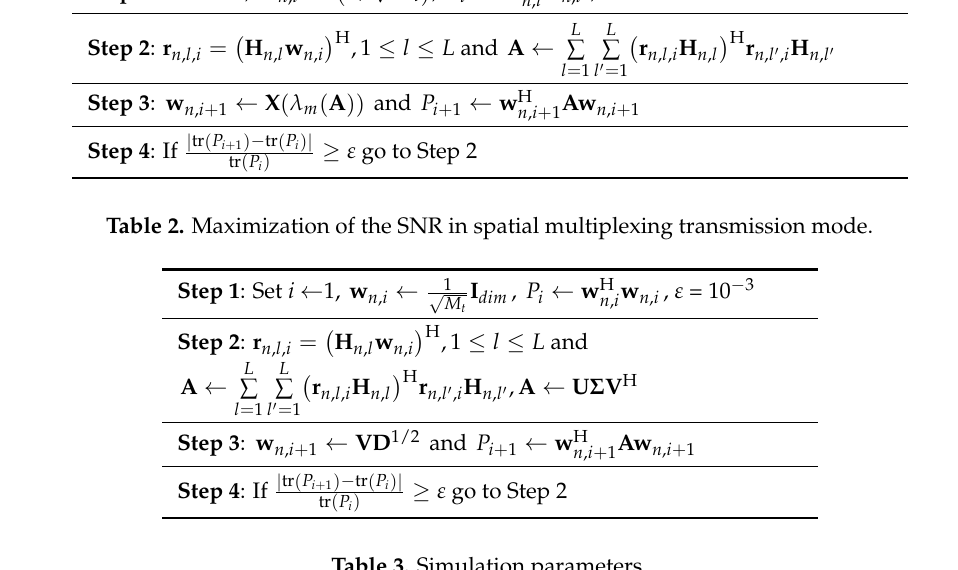
Table 3. Simulation